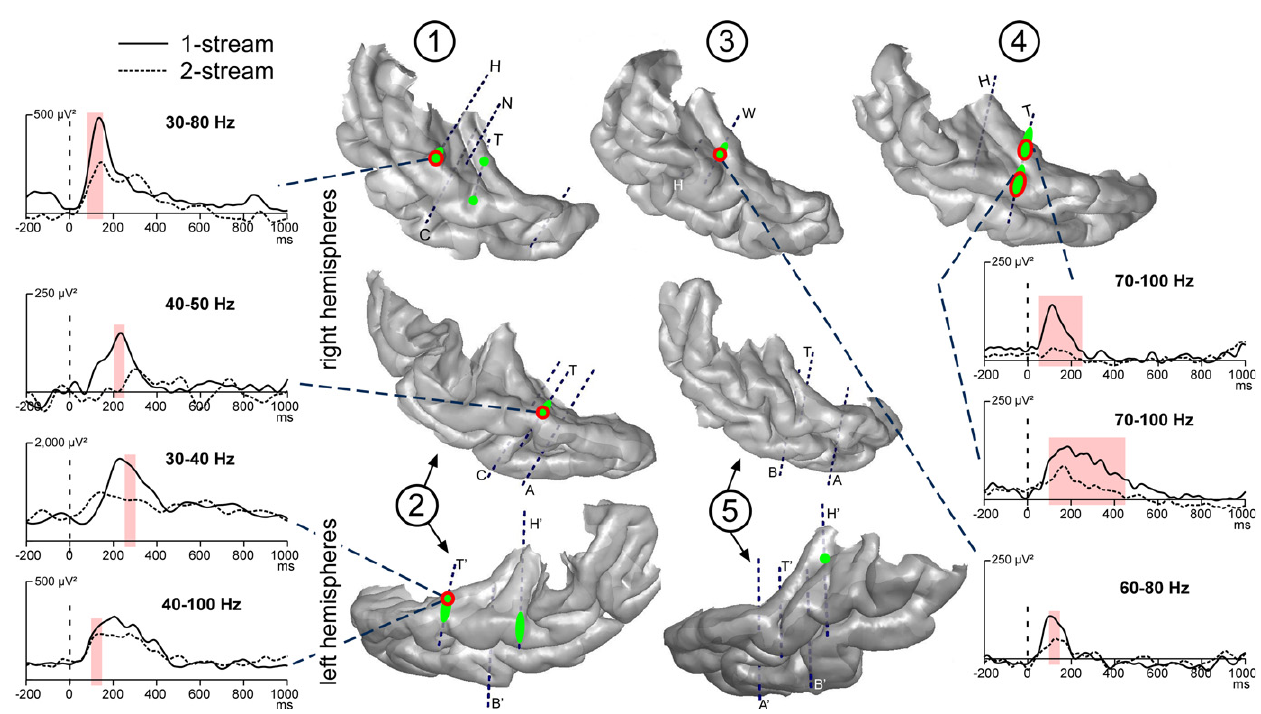
Figure 5. Emergence and modulations of induced gamma oscillations on the 3D rendering of individual temporal cortices. Emergence of induced gamma oscillations after the onset of part 2 (0 ms) is depicted in green. Induced gamma oscillations were emerging quite laterally in the HG and STG. They were found more prominent in the 1-stream condition, in four patients (‘1-stream > 2-stream’, red circles). At each electrode contact, signifi cant effects were found in a specifi c frequency band. The gamma power time profi les of the corresponding frequency bands are plotted (signifi cant differences are indicated by light- red shaded areas). The power of these oscillatory activities is baseline corrected with respect to the (−250, −150 ms) period preceding part 1. Each number corresponds to a patient, patients #2 and 5 being implanted in both hemispheres.